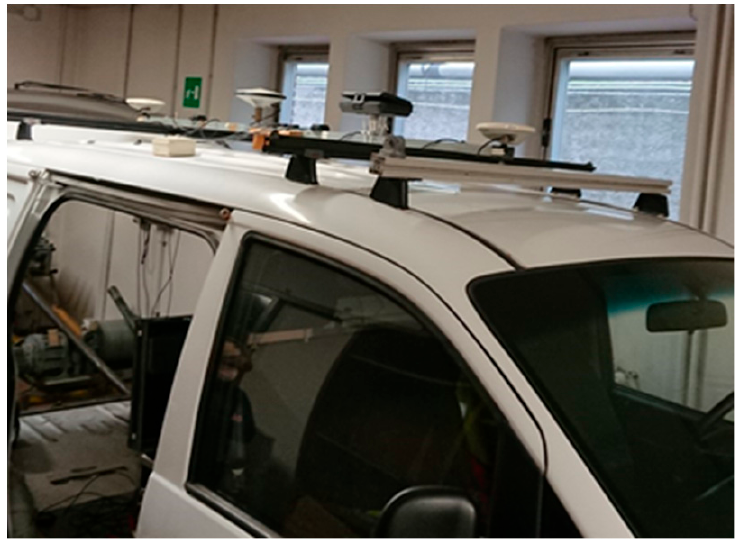
Figure 1. ( a ) The MMS of the GeoSNav Lab vehicle, University of Trieste, with the GNSS antennas mounted on the roof; ( b ) the setup of the instruments inside the vehicle.